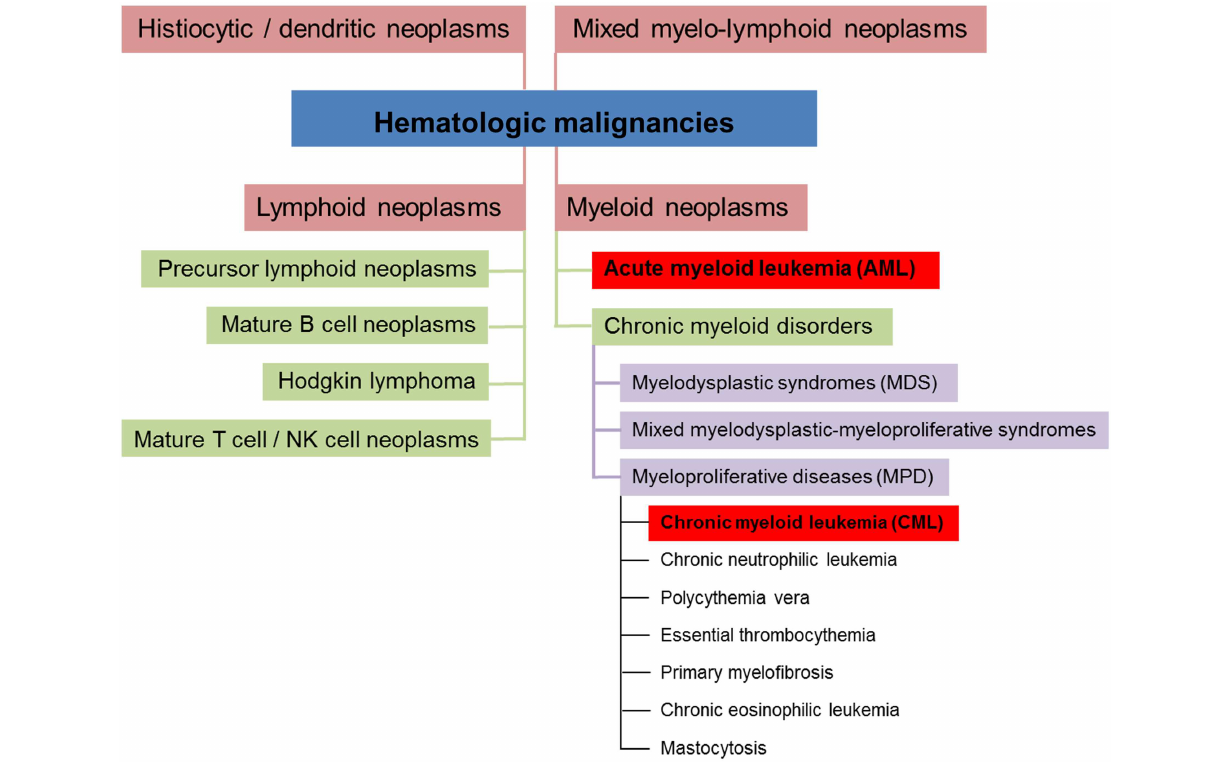
FIGURE 1 | Conceptual classification of hematologic neoplasms [based on data from Ref. (5, 6)] .